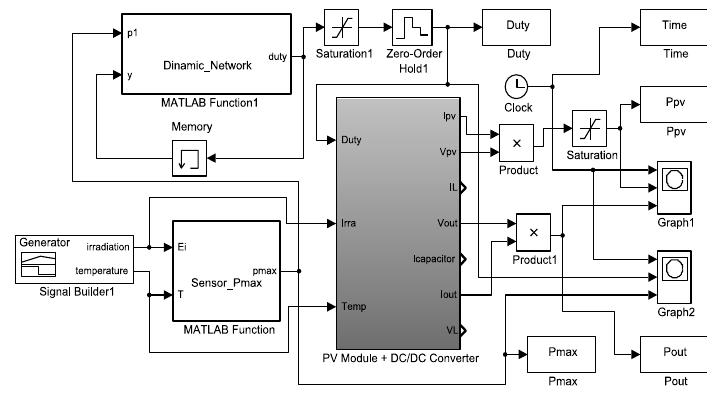
Figure 10. PV system in Simulink.